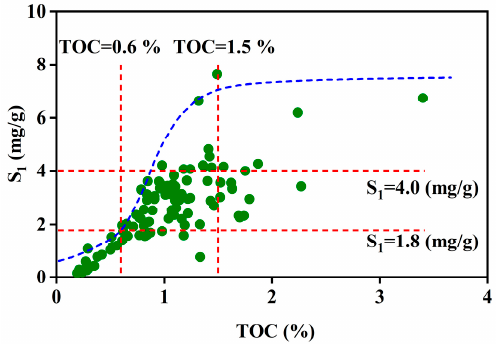
Figure 6. Relationship between TOC and S 1O .